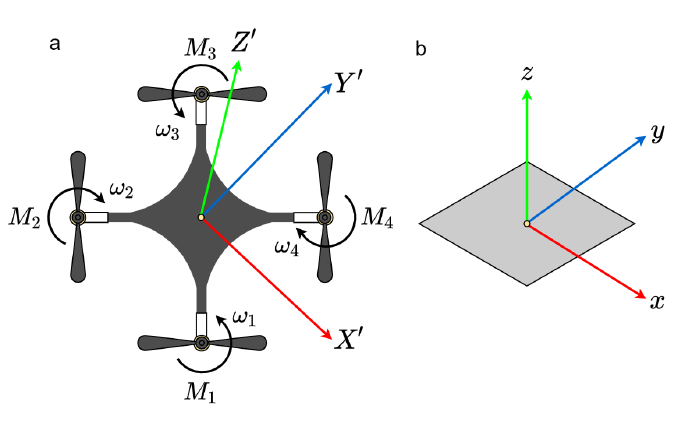
Figure 3. Nano-quadcopter. ( a ) Body frame. ( b ) Inertial